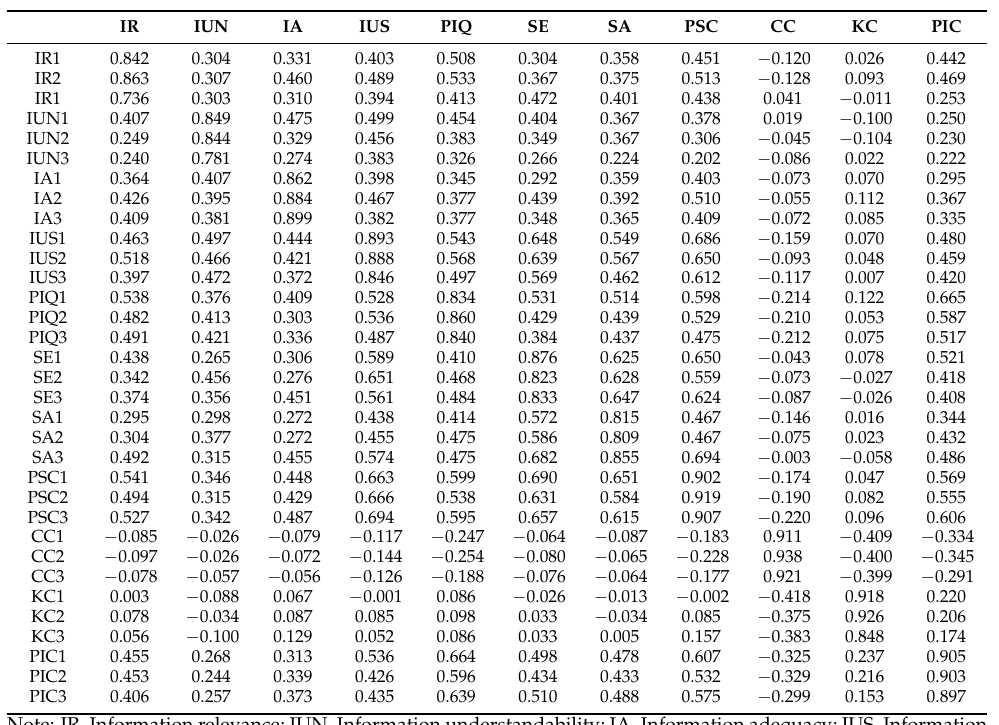
Table 4. Item factor loadings and